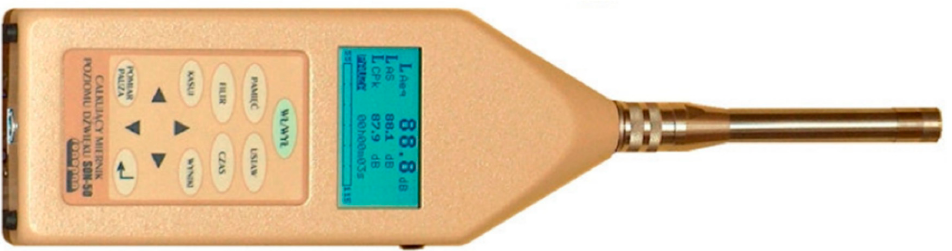
Figure 1. View of the Sonopan SON-50 device.